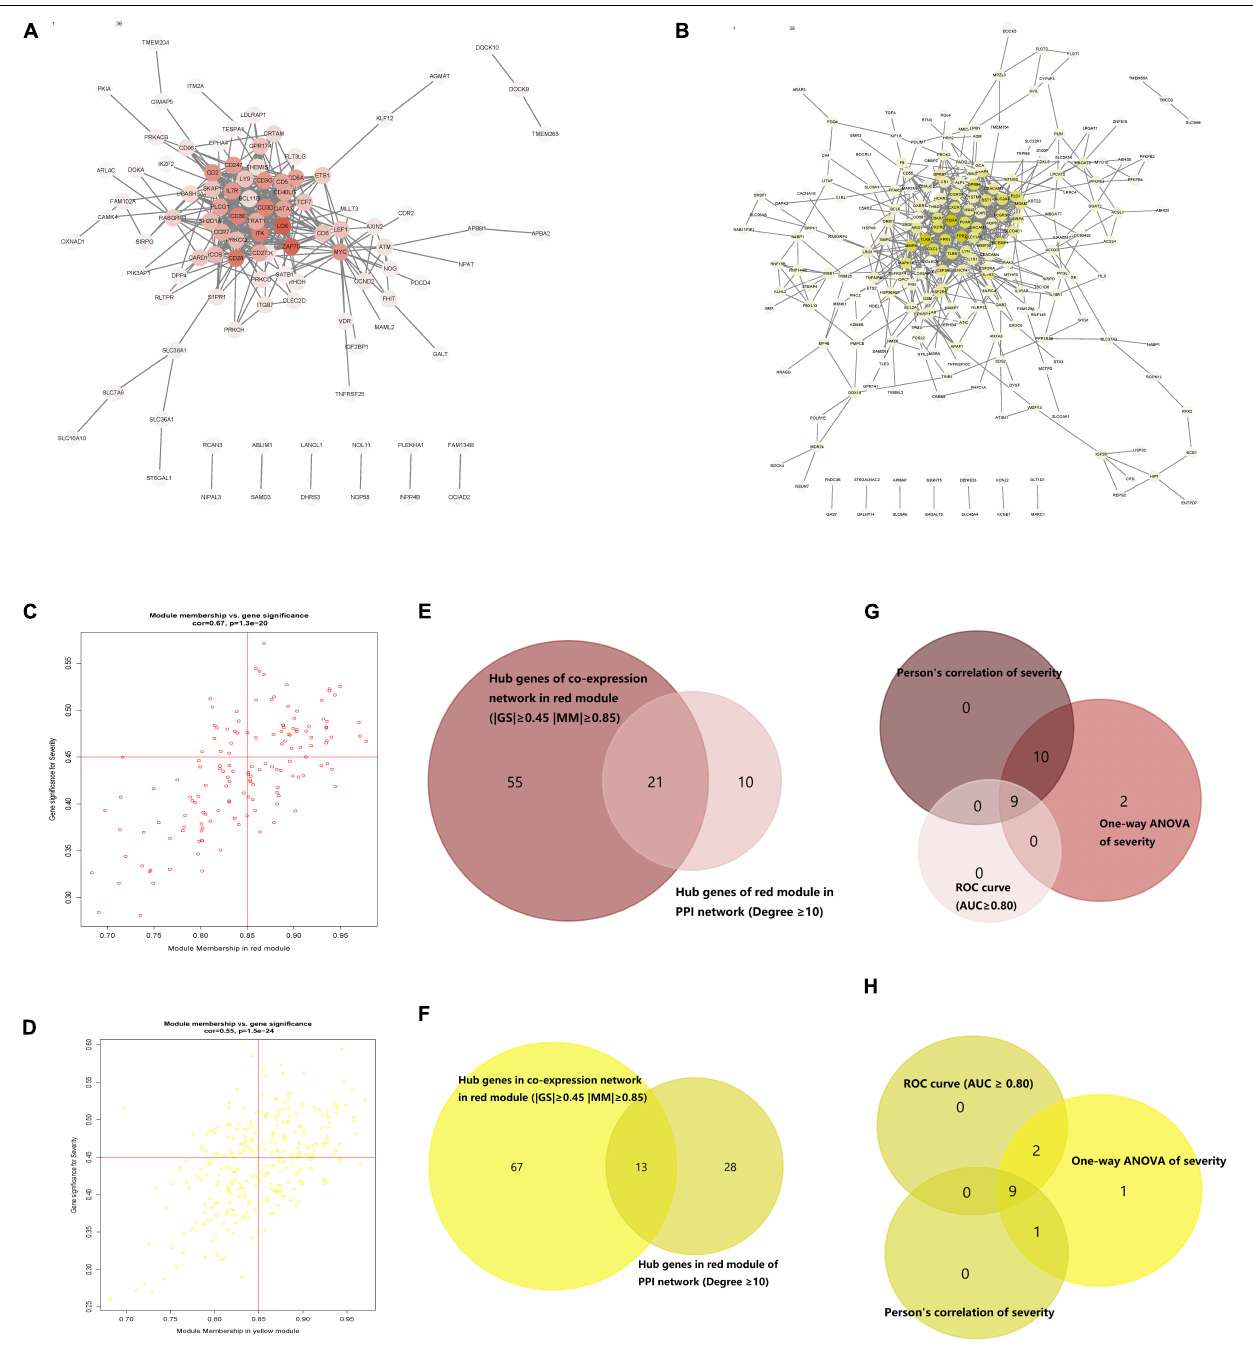
FIGURE 4 | Protein–protein interaction (PPI) networks of genes corresponding to the two key modules. (A) PPI network of the nodes in the red module. (B) PPI network of the nodes in the yellow module. (C) Scatter plot of module eigengenes (MEs) in the red module. (D) Scatter plot of MEs in the yellow module. (E) Common red hub genes in the co-expression and PPI networks. (F) Common yellow hub genes in the co-expression and PPI networks. (G) Common genes in the red module shared characteristics with an area under the curve (AUC) ≥ 0.80 and had significant P values in the Pearson’s correlation and one-way ANOVA tests. (H) Common genes in the yellow module shared characteristics with an AUC ≥ 0.80 and had significant P values in the Pearson’s correlation and one-way ANOVA tests.